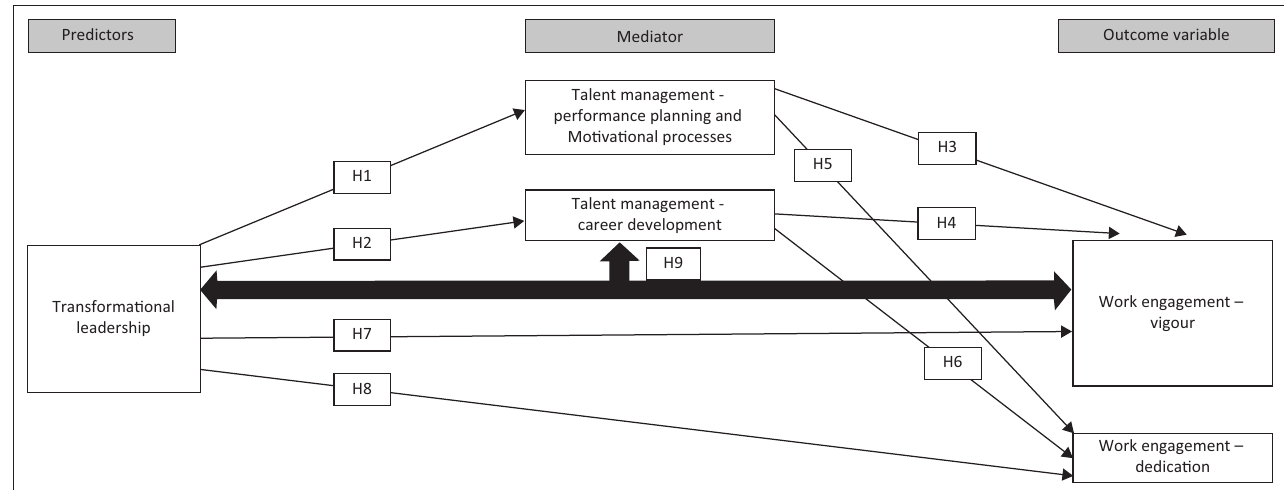
FIGURE 1 : Hypothesised relationships and conceptual